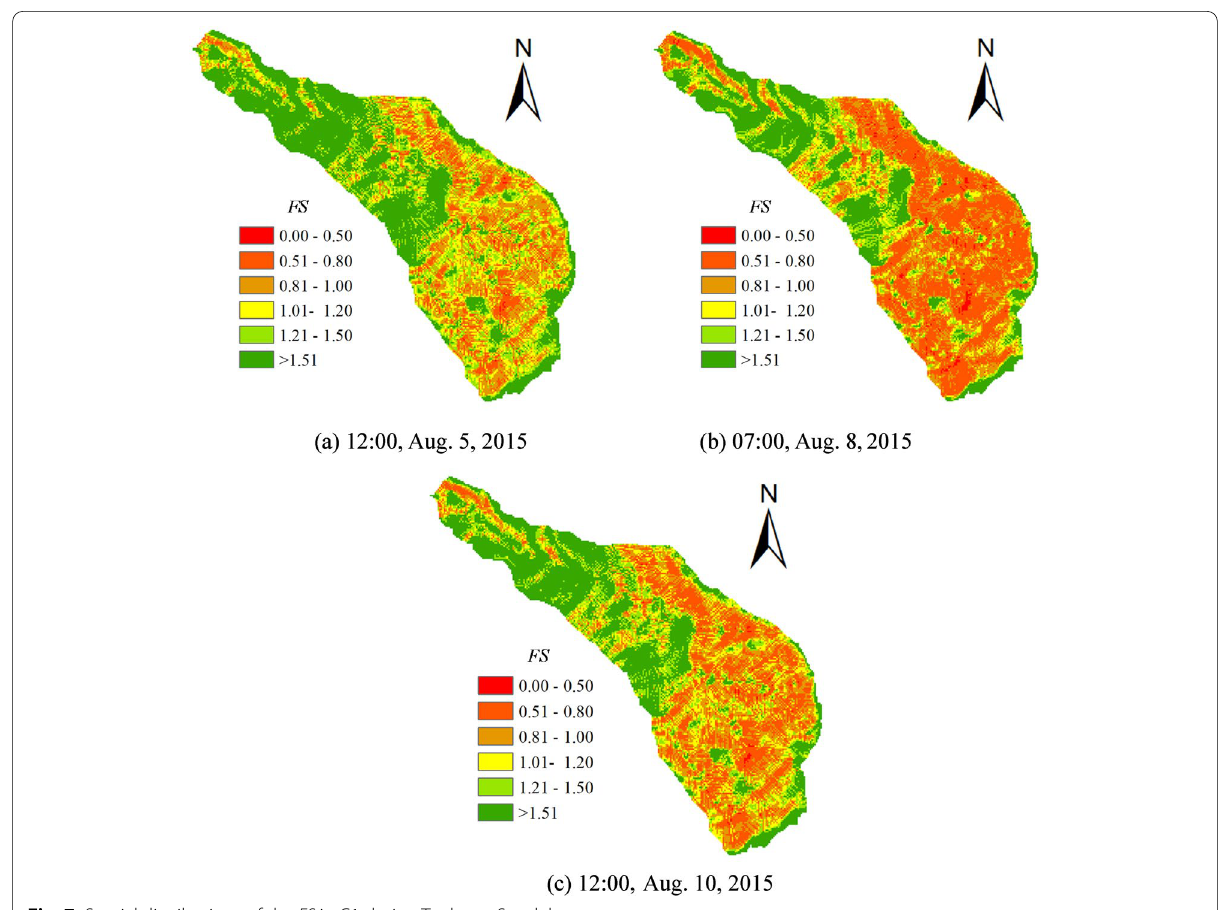
Fig. 7 Spatial distributions of the FS in C1 during Typhoon Soudelor